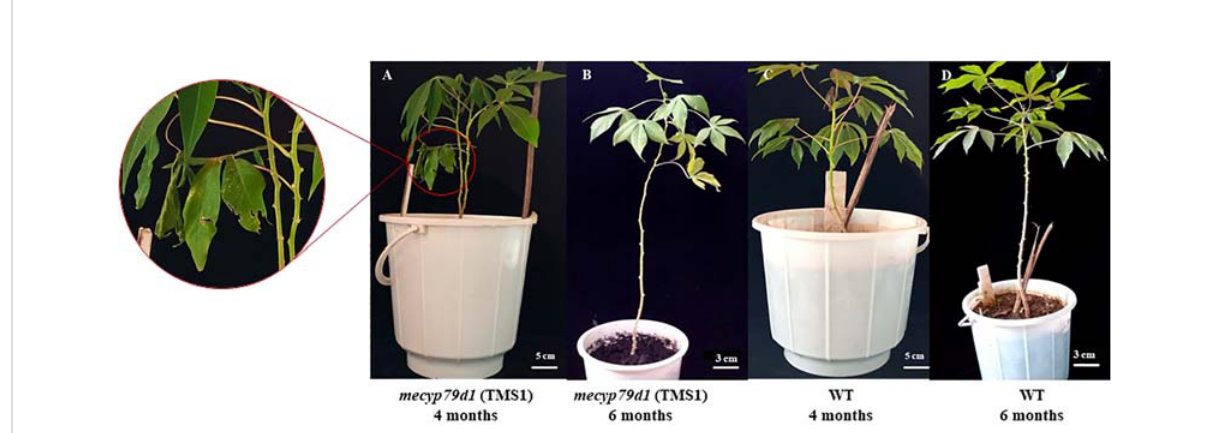
FIGURE 5 Morphological phenotype of the TMS1 mecyp79d grown alongside the wild-type (WT) control in the greenhouse. (A) 4 month old TMS1 mecyp79d cassava plant; (B) 6 month old TMS1 mecyp79d cassava plant; (C) 4 month old WT cassava plant; (D) 6 month old WT cassava plant.